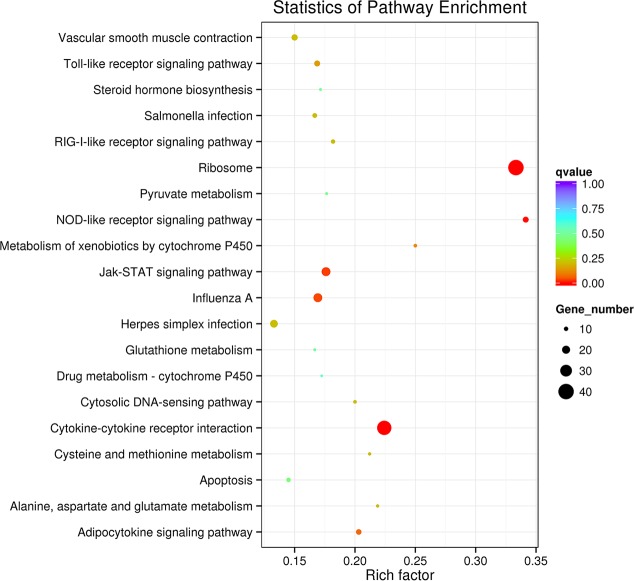
KEGG enrichment analysis of DEGs in the pulmonary artery.The most 20 KEGG pathways were presented. The y-axis and x-axis indicate pathway name and rich factor, respectively. The size of circle dot means gene number.